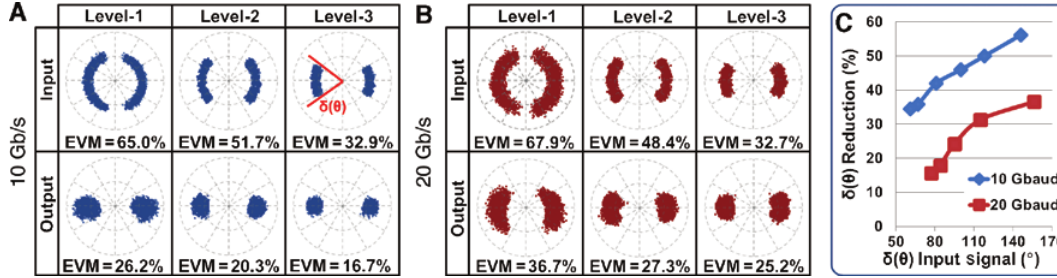
Figure 26: Brillion phase squeezing results.